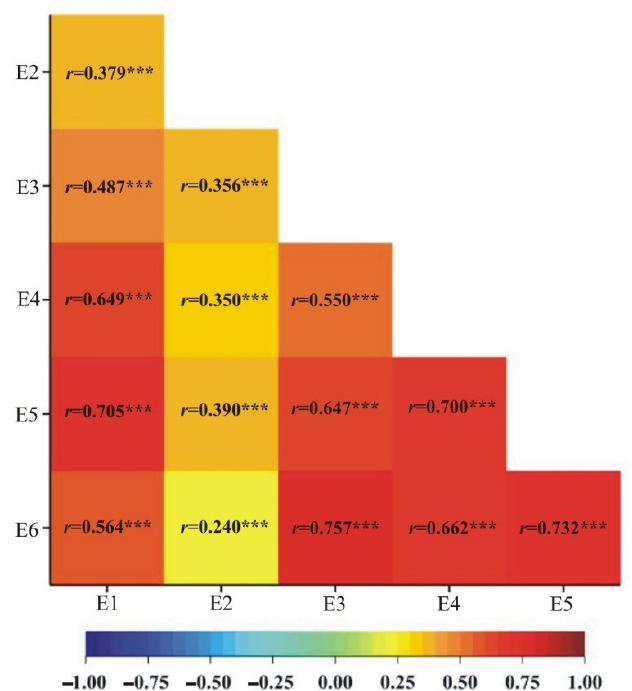
Figure 10. Relationships between Mahalanobis distance within the studied environments. E1— Borowo, 2015; E2—Borowo, 2016; E3—Borowo, 2017; E4—Łagiewniki, 2015; E5—Łagiewniki, 2016; E6—Łagiewniki, 2017.*** p < 0.001.